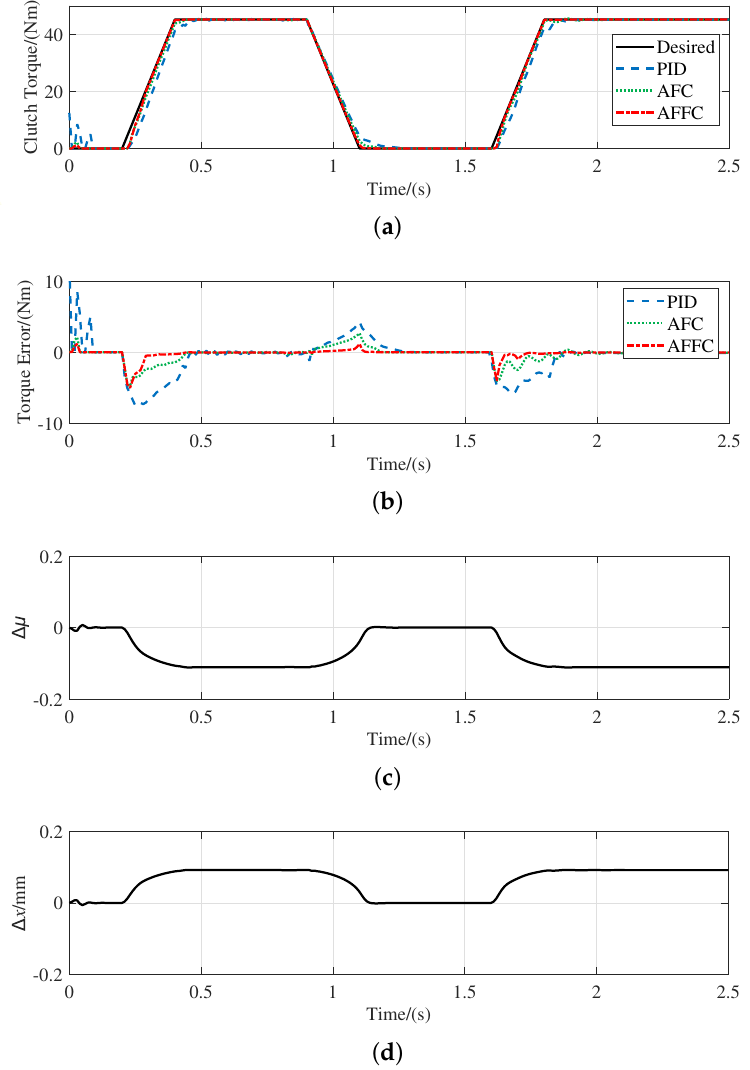
Figure 11. Performance comparison of torque loop controllers under the second simulation condition: ( a ) Clutch Torque; ( b ) Torque Error; ( c ) Friction Coefficient Uncertainty; ( d ) Translation Amount. It can be seen from Figure 10 that when the clutch model has not changed, the three controllers all show good control effects. The tracking error mainly exists in the torque phase, because the clutch reference torque changes from a constant state to a linear change state similar to the ramp signal in the torque phase. For example, at 0.2 s, the PID controller has a certain degree of tracking hysteresis, and the settling time is about 0.3 s, basically occupying the whole first torque phase. Compared with the PID controller, the AFC and AFFC have faster response speeds. The settling time of the AFC is about 0.25 s, and the AFFC has the least settling time of 0.1 s. In Figure 11, the clutch model changes due to the influence of time-varying parameters. Although the settling time of the three controllers remains the same as that of the first simulation condition, the tracking errors have slightly increased. The PID controller is greatly affected by the change of clutch model, especially in the inertial phase, a slight buffeting phenomenon occurs, and the buffeting amplitude is about 0.4 Nm. Figure 11c,d show the adaptive estimations of the friction coefficient uncertainty and translation amount of AFC and AFFC. Two parameters are constantly corrected as the clutch reference torque changes. The steady-state values of the two parameters are − 0.111 and 0.092, respectively, close to the set value, and the time-varying parameter adaptive estimation is basically realized. Because of the